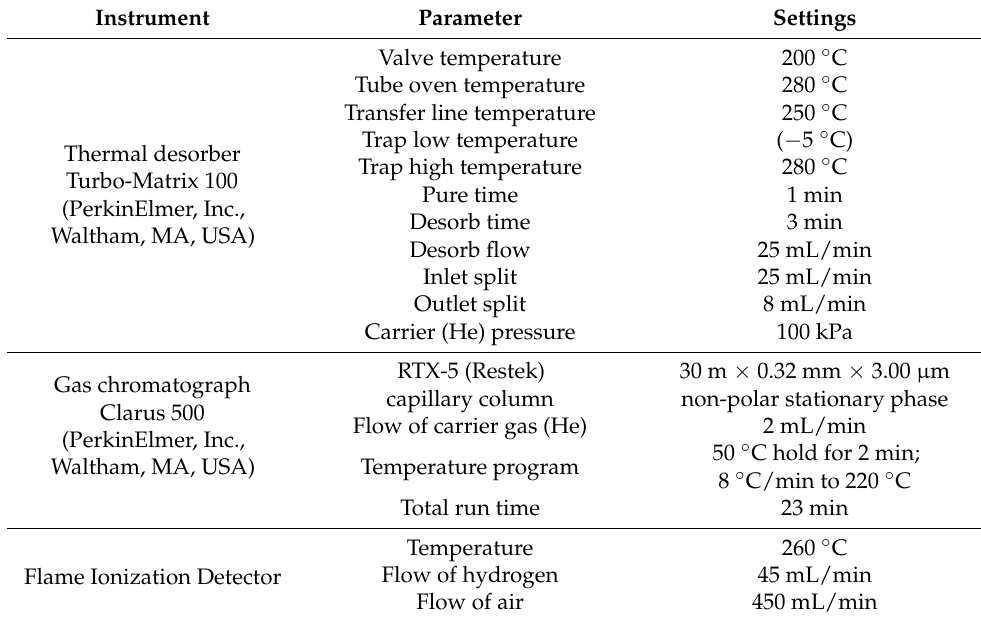
Table 1. Thermal desorption-gas chromatography with flame ionization detector (TD-GC/FID)